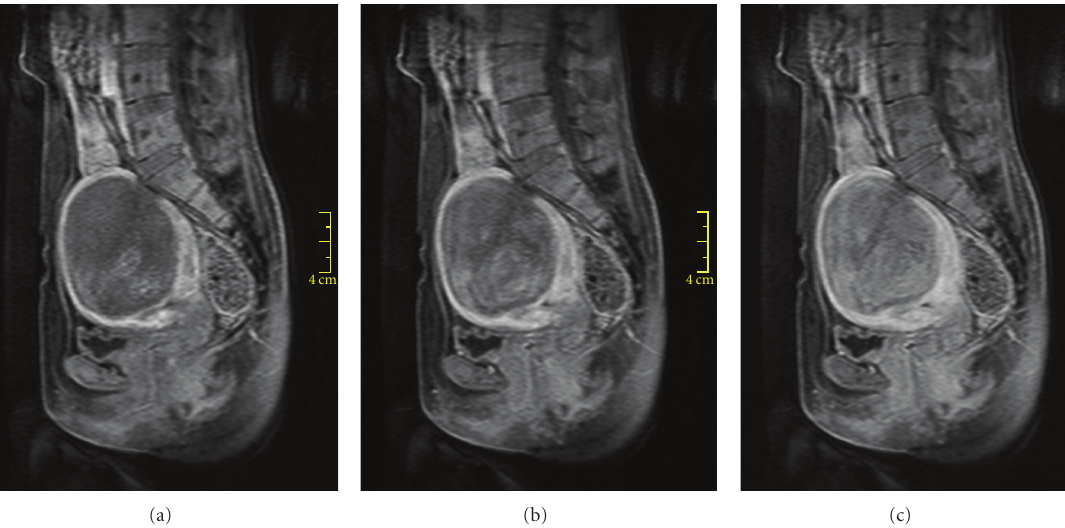
Figure 2: Contrast-enhanced sagittal T1-weighted screening MR dynamic images acquired at 30, 60, and 90 seconds post contrast injection (from left to right). Fibroid shows lower enhancement than the myometrium in the first 2 minutes postinjection.